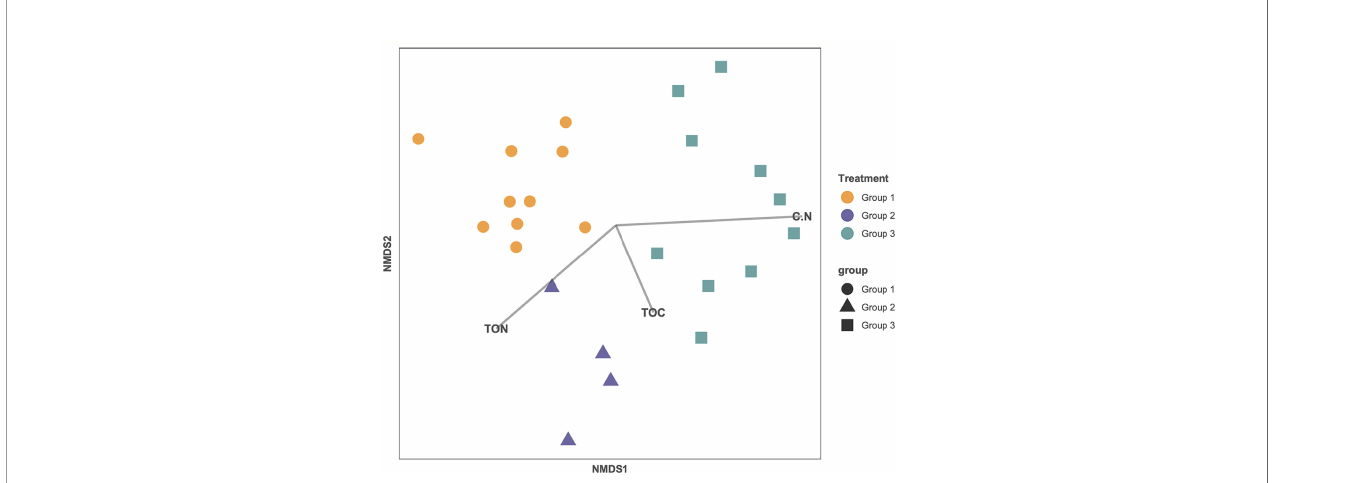
FIGURE 5 | Non-metric multidimensional scaling (NMDS) ordination of each sample based on their microbial composition. Groups previously identi fi ed are labeled as orange circles (Group 1), blue triangles (Group 2), and teal squares (Group 3). Each line is correlated to the ordination and represents the direction and strength of the carbon in fl uence (C:N ratio, OC, and TN). C:N ratio is signi fi cantly correlated (p =